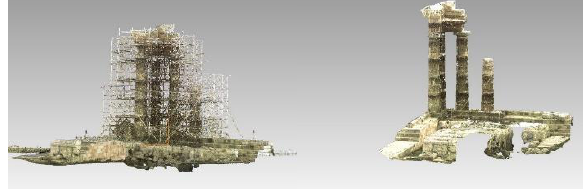
Figure 3: Point cloud of TLS before (left) and after (right) the removal of noise; West façade